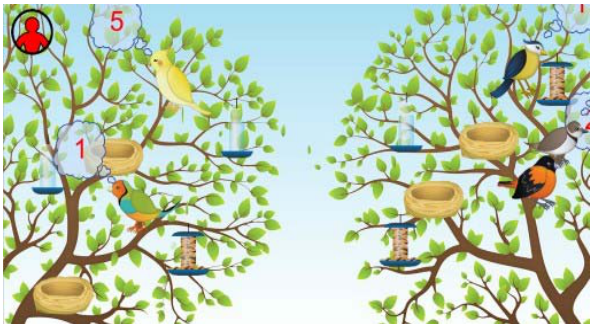
Figure 1. Ambient application showing the birds representing users and their activity level – data gathered from the